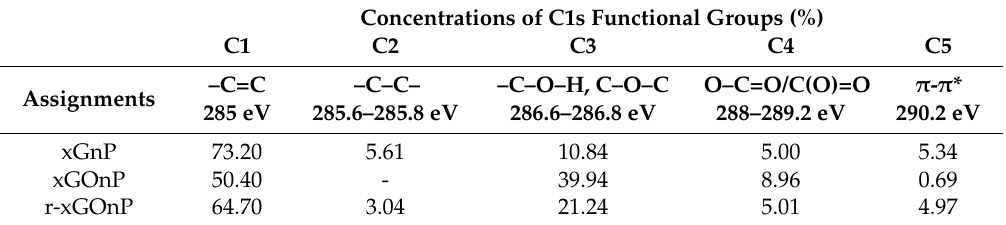
Table 2. Interpretation of the de-convoluted C1s peaks and their relative atomic percentages, obtained from XPS results, for xGnP, GONs, GONs-OA, and GONs-OA-PP.